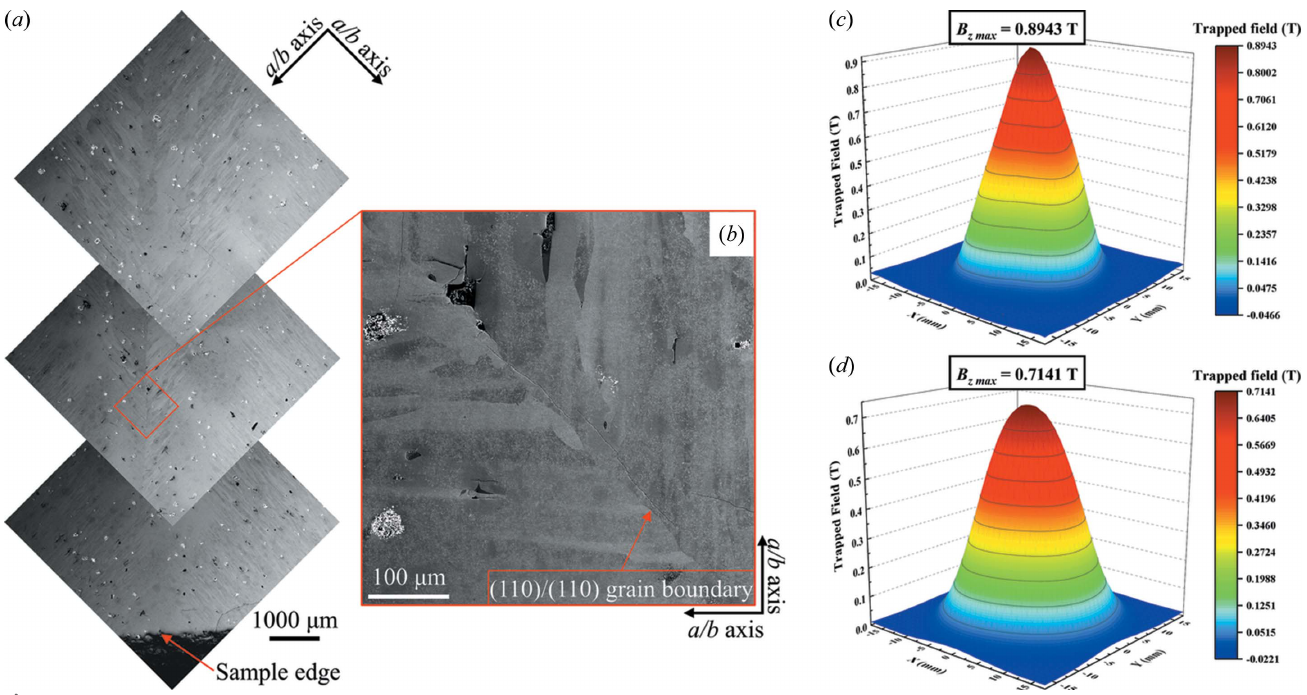
Figure 5 ( a ) SEM micrographs of an (110)/(110) ISSA seeded sample from the middle to the edge. ( b ) Local SEM image at a higher magnification showing the details of the (110)/(110) grain boundary. ( c ) and ( d ) Trapped field profiles (3D maps) measured at top surfaces of samples in Fig. 4( a ) and 4( c ).